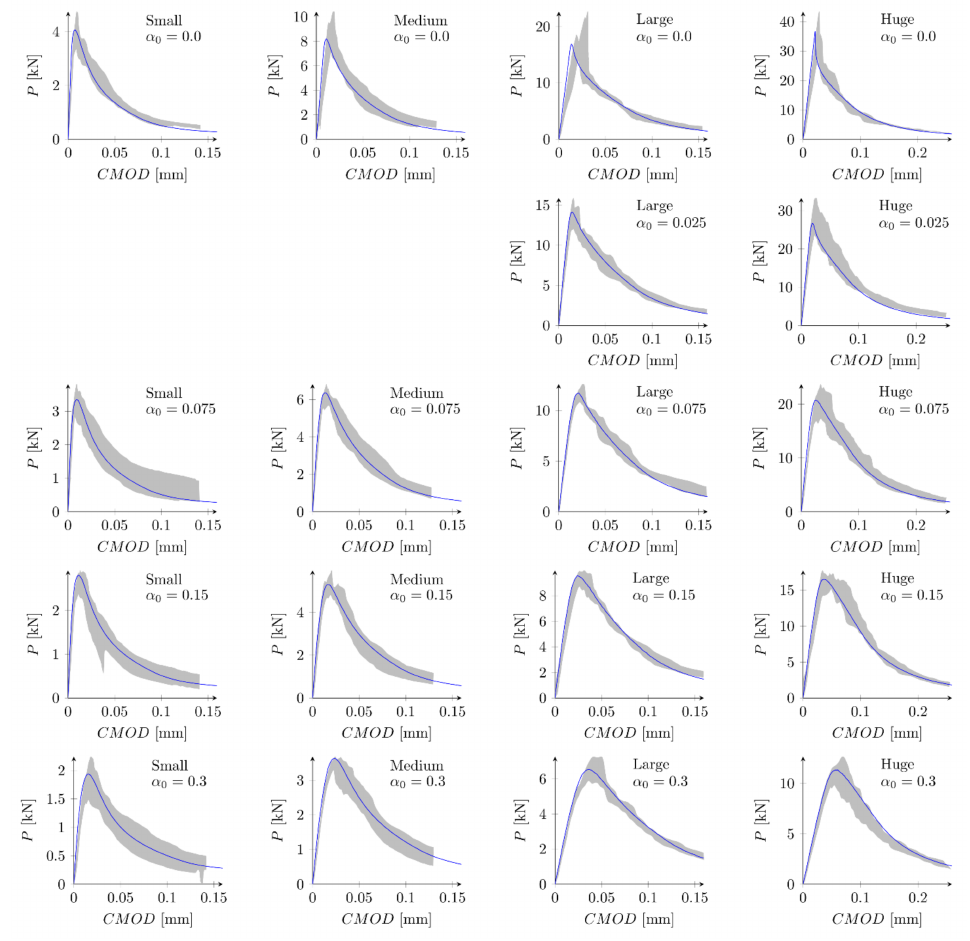
Figure 15. Experimental and numerical force—crack mouth opening displacement curves for rational Bezier softening and set S13: f t = 5.2 MPa, G f = 35 N/m, w =